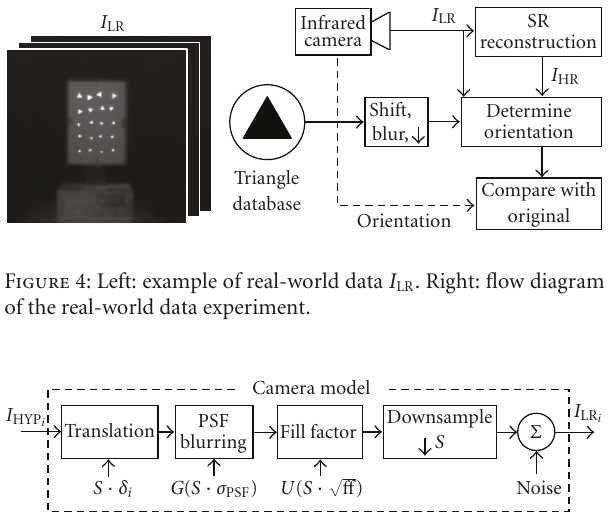
Figure 3: Example of a possible Weibull distribution of probability correct observer response.